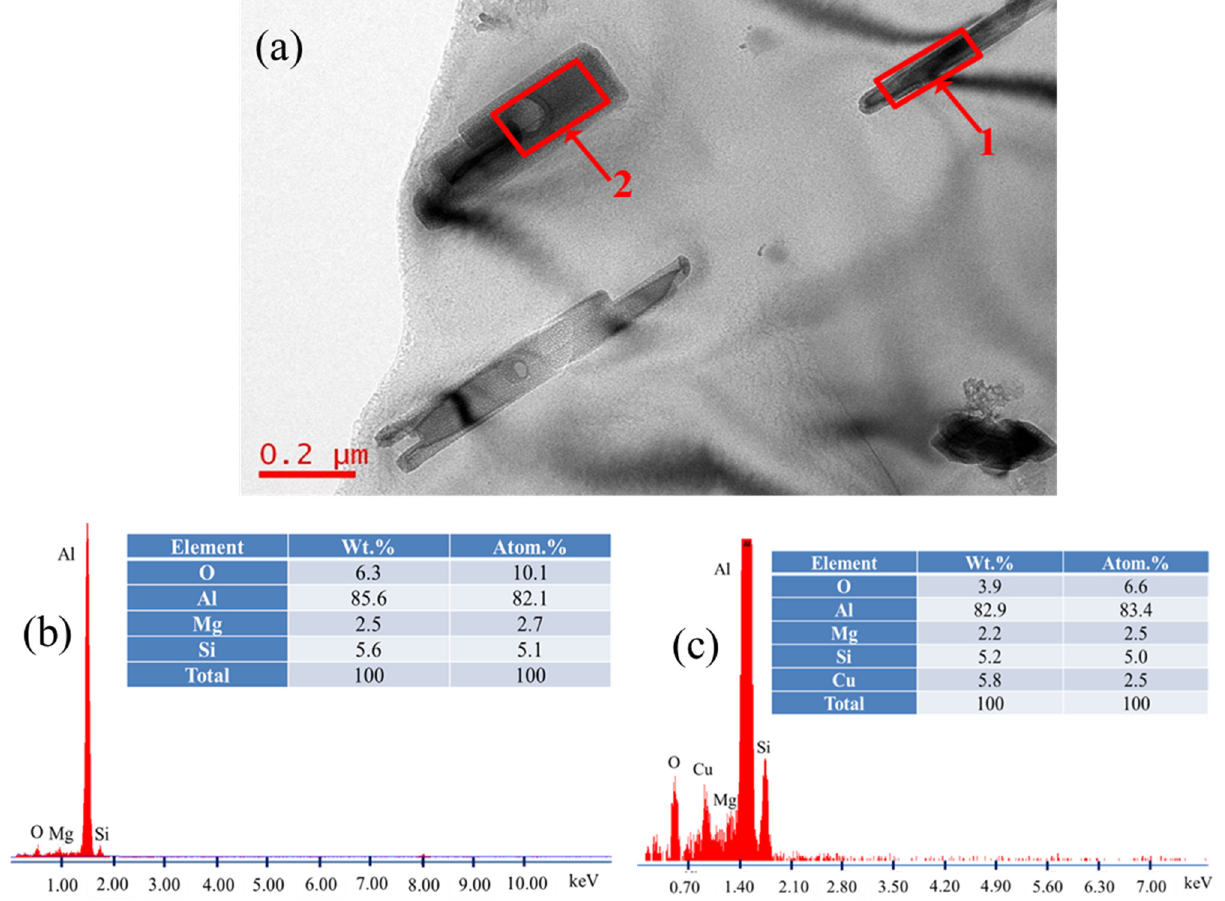
Figure 10. ( a ) TEM bright-field image of Al clad sheets (core layer) and TEM-EDX analysis of precipitates ( b , c ) corresponding to the red arrows 1 and 2, respectively. (brazed state).